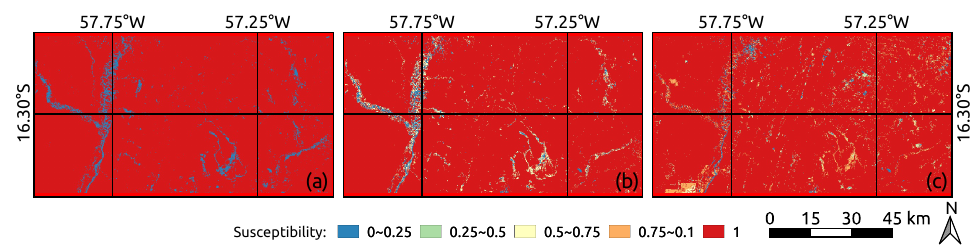
Figure 10. Fire susceptibility maps for Area 2 with OC-SVM method as anomaly detection model. Subfigures ( a – c ) refer to mappings based on the “analysis period” of epochs I, II, and III,